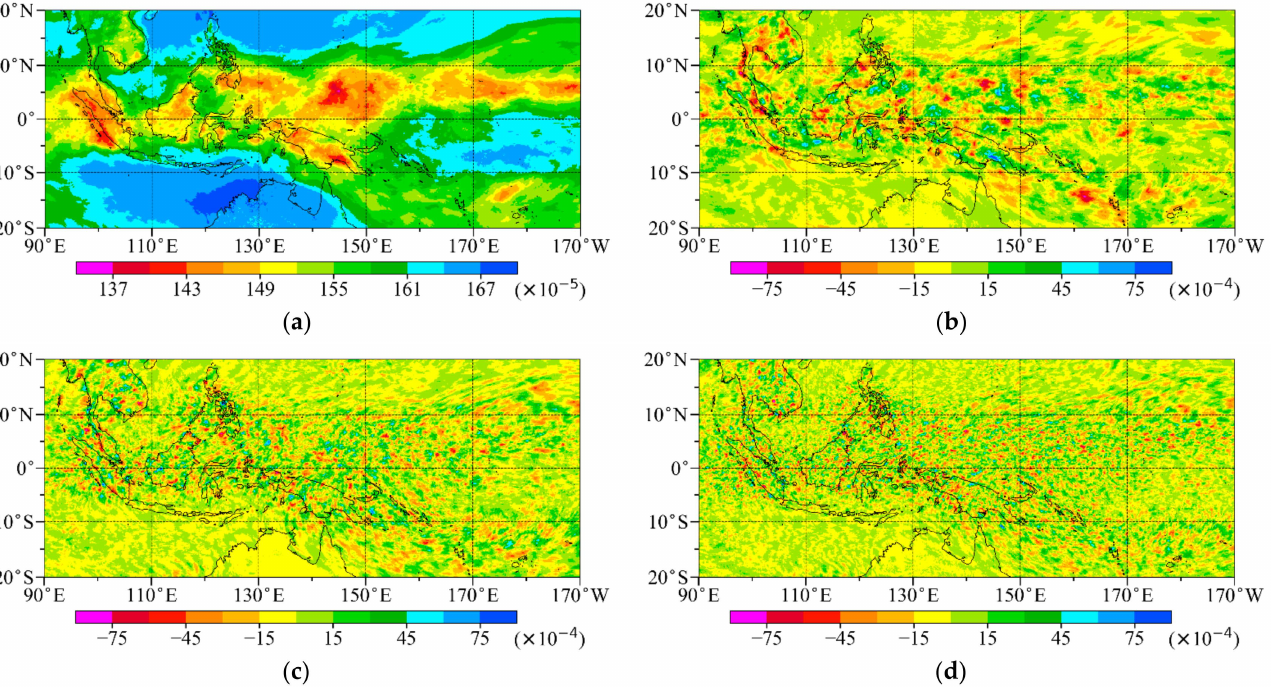
Figure 6. Horizontal distributions of ( a ) the first, ( b ) the 20th, ( c ) the 40th, and ( d ) the 60th PC modes → → → → e 1 , e 20 , e 40 , and e 60 ) of the AHI brightness temperature observations. (i.e., The first, 20th, 40th, and 60th PC coefficients (